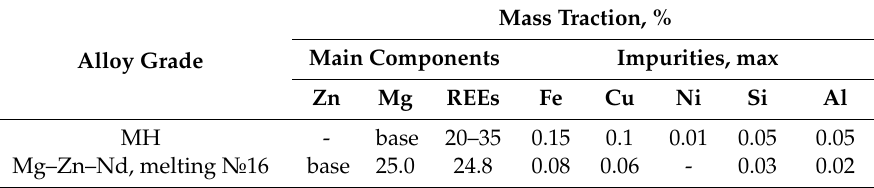
Table 3. Chemical composition of Mg–Zn–Nd master alloy.